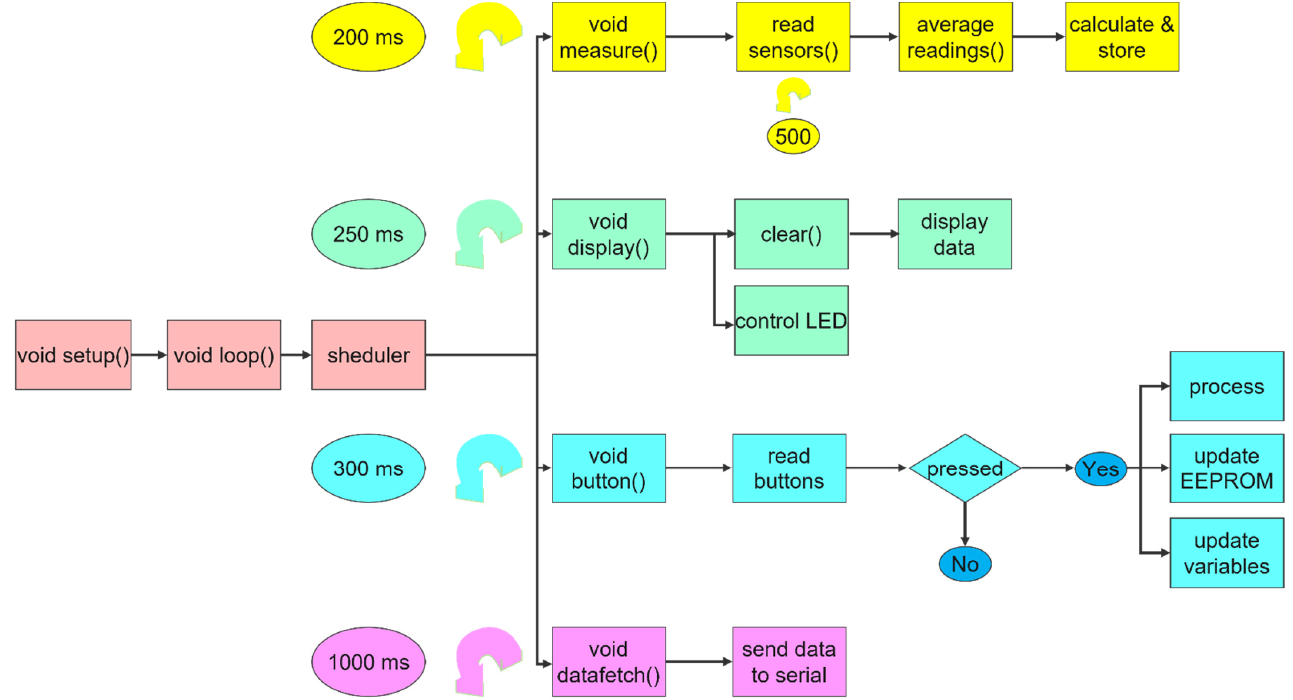
Figure 9. Logic diagram of the firmware.